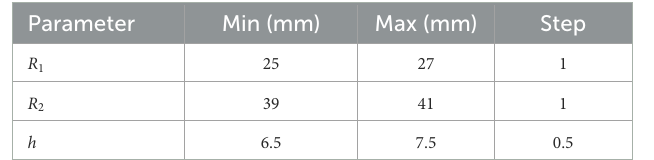
TABLE 5 Parameter ranges and steps for the second iteration.